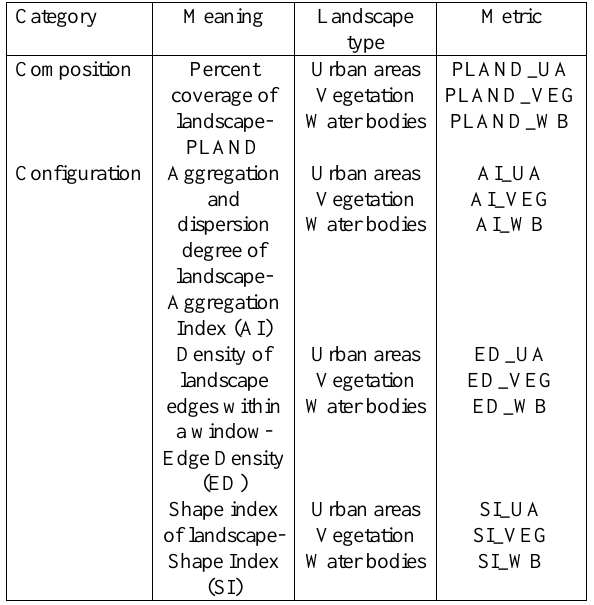
Table 1. Landscape metrics used in this study